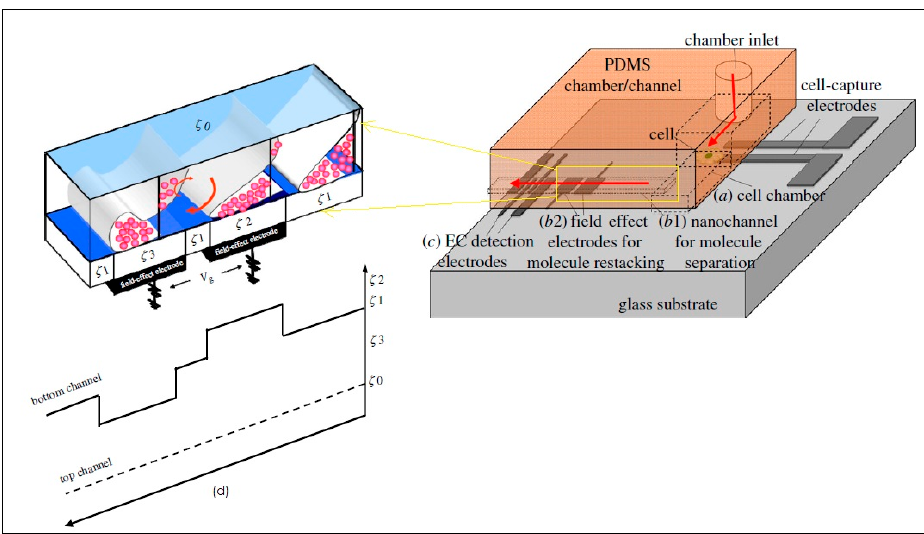
Figure 30. Schematic representation of a Nano-CEEC chip designed for living single-cell analysis.